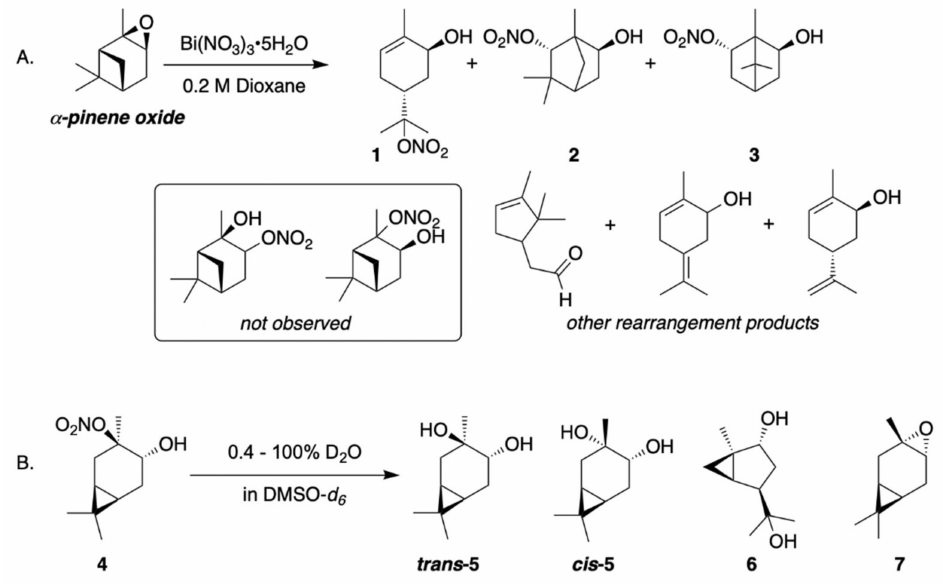
Figure 3. ( A ) Rearrangement products observed in the synthesis of HN from α -pinene oxide [32]; ( B ) hydrolysis and rearrangement products observed from carene HN 4 [31].